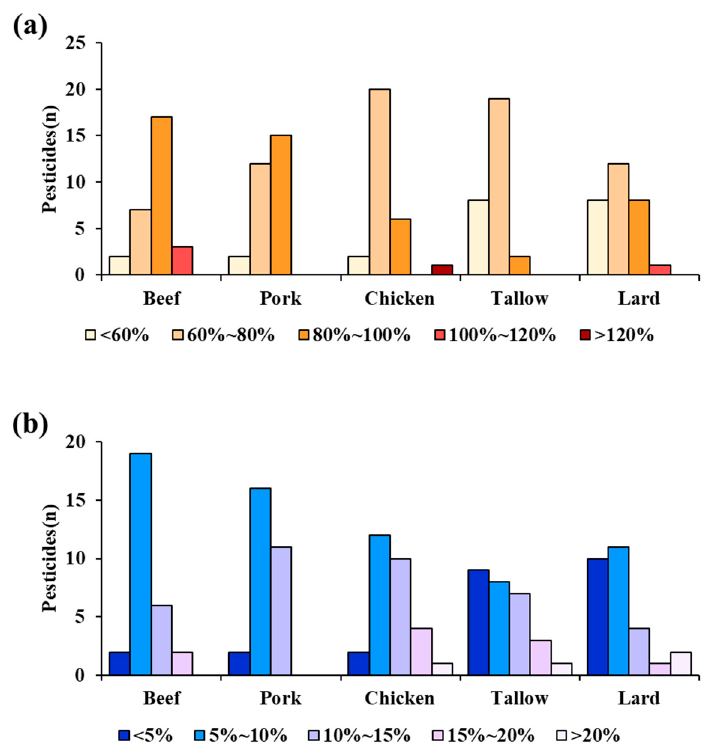
Figure 3. ( a ) Distribution of overall recoveries and ( b ) RSD (in percent, n = 5) of the 32 compounds in beef, pork, chicken, tallow, and lard samples, which were obtained using the developed method.